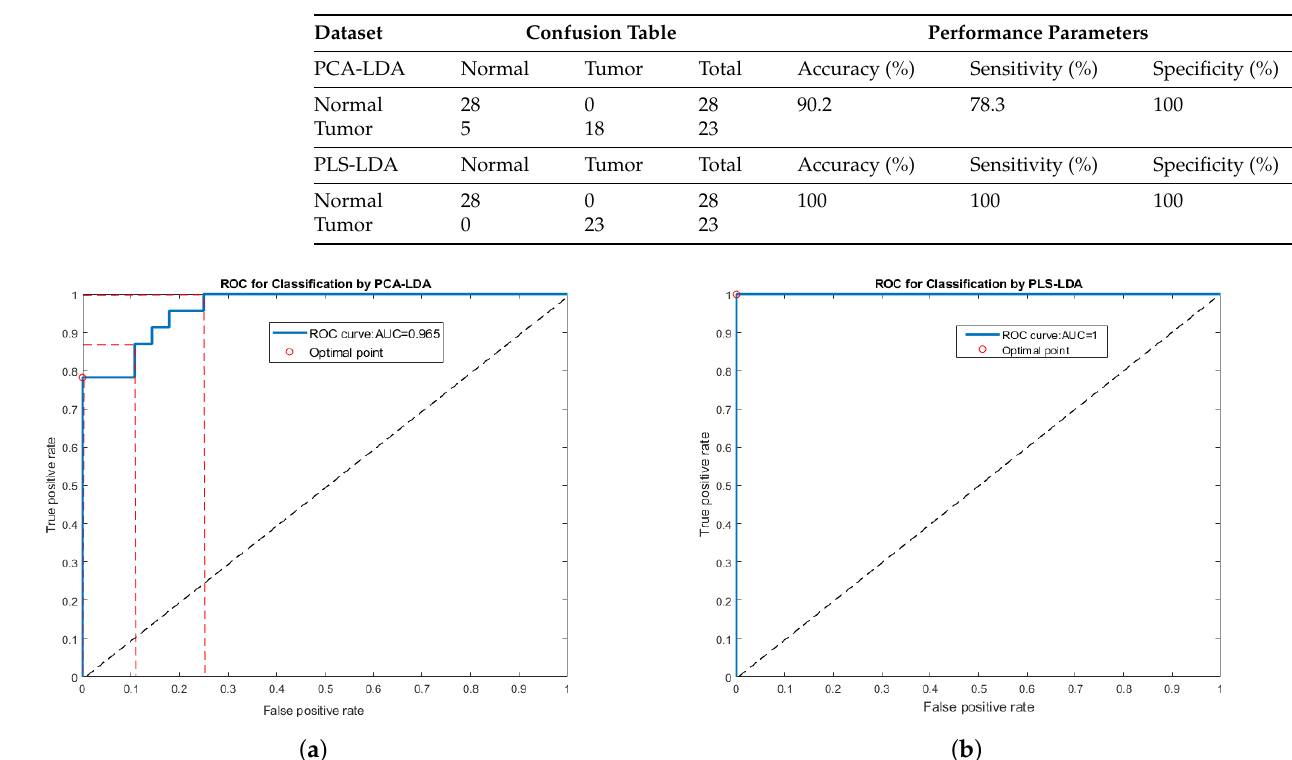
Table 3. Validation set misclassifications and performance tables of PCA-LDA and PLS-LDA models.